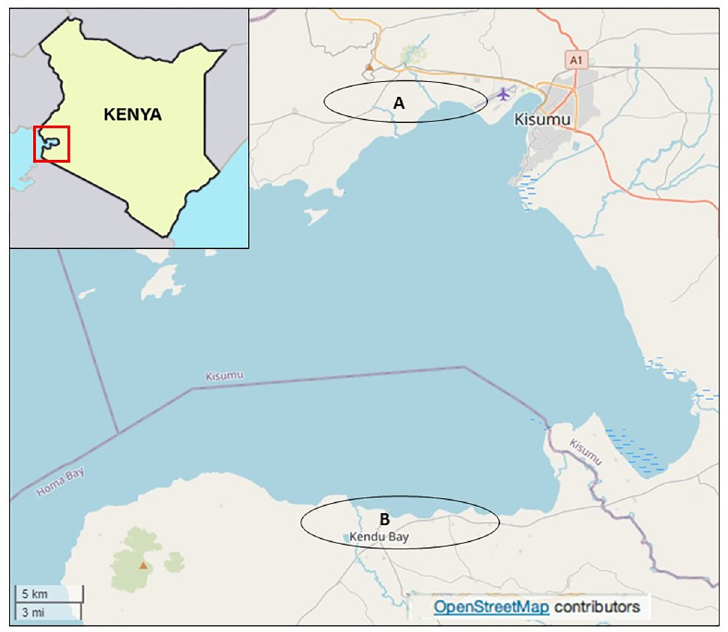
Fig 1. Study sites in western Kenya. (A) Kisumu West and (B) Rachuonyo North sub-counties, https://opensource. com/.